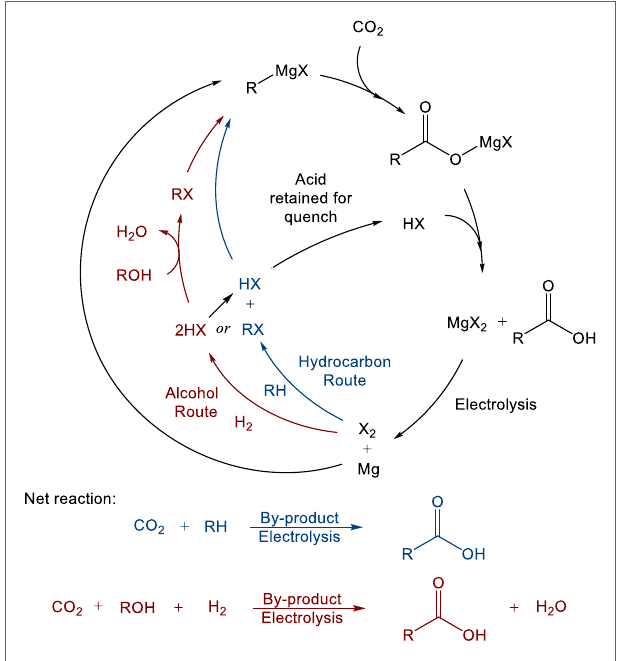
FigUre 3 | General Grignard CO 2 reaction/cycle scheme including Grignard regeneration using alcohols or hydrocarbons as starting